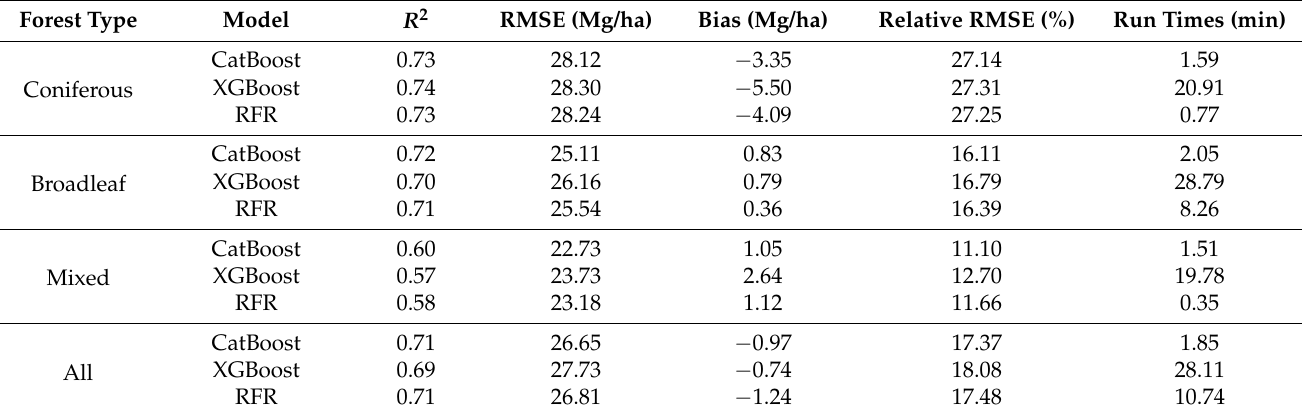
Table 6. AGB estimation accuracy assessment on validation dataset by combining LASSO with machine learning algorithms for different forest types.